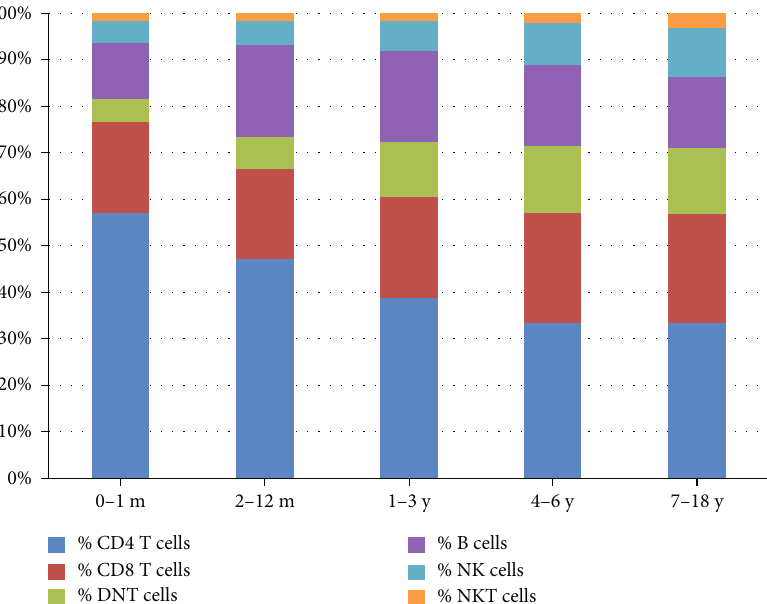
Figure 3: Cell-subset percentages of peripheral blood lymphocytes in Chinese children: distribution by age. Median values of percentages of T cell, CD4 T cells, CD8 T cells cell, DNT cell, B cell, NK cell, and NKT